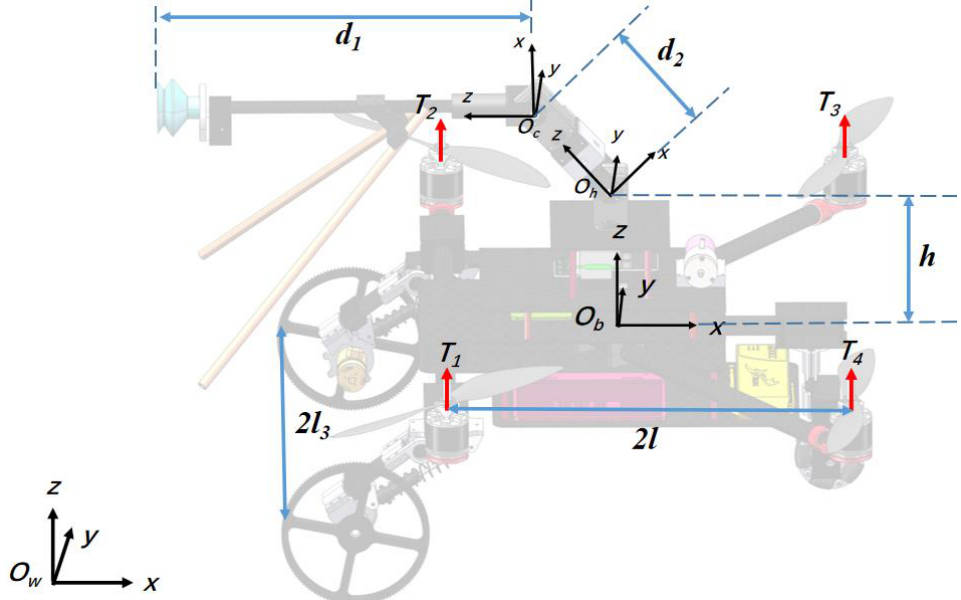
Figure 2. Structure and coordinates of the robot (LAWCDR).